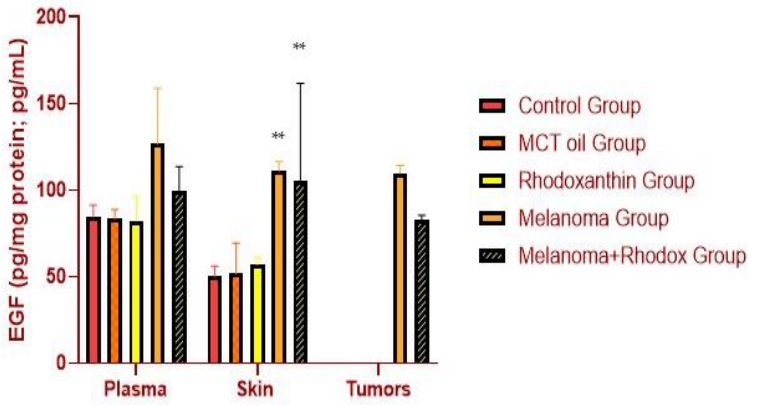
Figure 9. EGF variation within the groups. Statistical significance level ** p < 0.01.